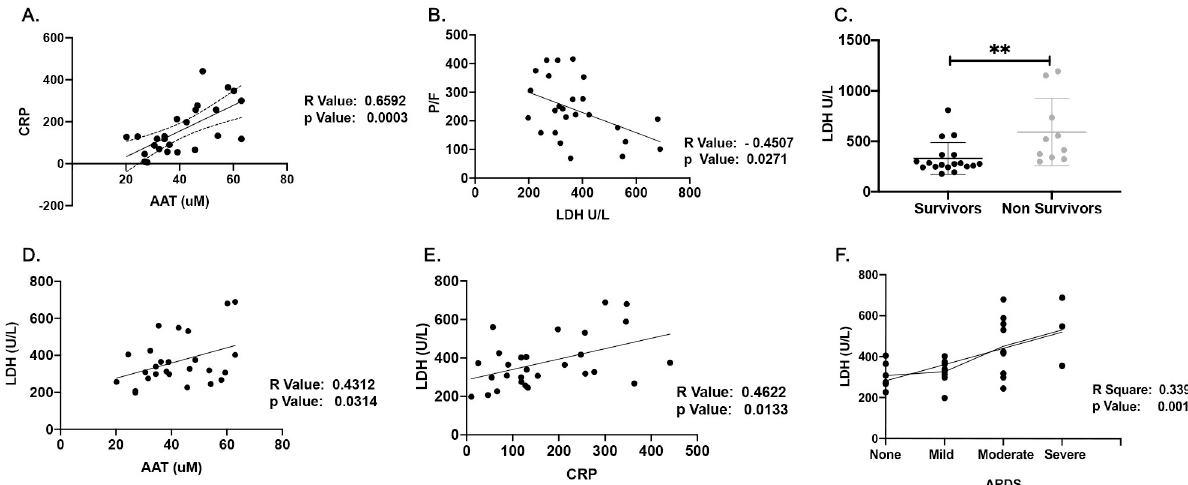
Fig 2. Correlations among plasma profiles in the SARS-CoV2 patients. (A) The correlation between plasma levels of CRP and AAT from COVID- 19 patients. (B) Negative correlation between PaO2/FiO2 levels and plasma LDH levels. (C) Plasma LDH levels in survivors compared to non- survivors. (D and E) The correlation of LDH levels and plasma levels of CRP and AAT. (E) Severity of ARDS based on PaO2/FiO2 ratio values, �� p < 0.005 (two-tailed Mann-Whitney U test, Pearson correlation